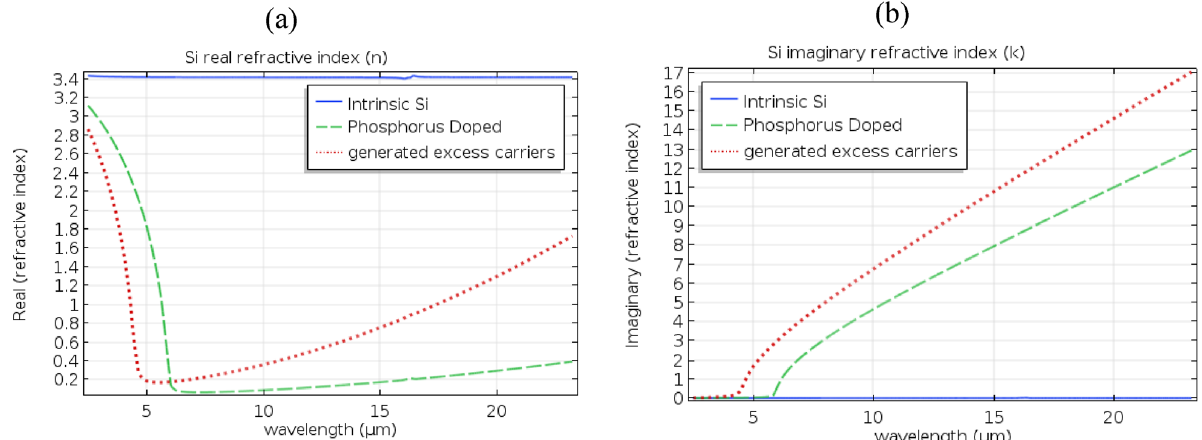
Figure 2. Real and imaginary components of the complex refractive index for intrinsic Si (solid-blue) based on curve fitting of the experimental results by Horowitz et al. and Palik 39,40 . An index perturbation model was utilized based on soref et al. and henry et al. 41–43 to introduce the plasma dispersion effect resulted from a concentration of 10 20 cm −3 free carriers in the case of excess carrier generation (dotted-red) and Phosphorus doping